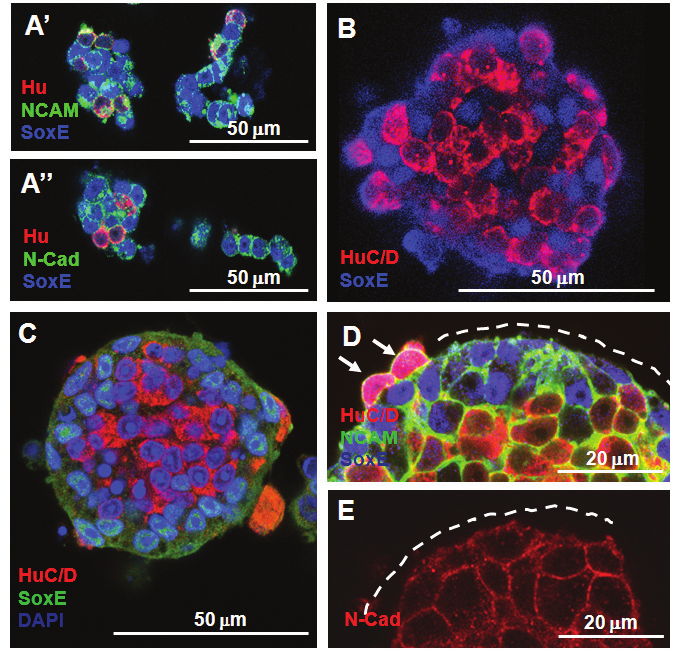
Figure 6. Formation of aggregates by ENS cells in cell-cell adhesion assays correlates with adhesion molecule expression pattern. A’ A’’ . At 2 h QE8 N-cadherin and NCAM +ve ENS cells formed small aggregates (mixed Hu +ve neurons and SoxE +ve ENC cells) and chains (mostly ENC cells). B . At 6 h spherical aggregates were formed but neurons (HuC/D +ve ) and ENC cells (SoxE +ve ) were only partially segregated. C . At 18 h most HuC/D +ve neurons formed the centre of each spherical aggregate surrounded by SoxE +ve ENC cells. D . NCAM immunoreactivity was low on the external face of SoxE +ve ENC cells (indicated by dotted line), but high around HuC/D +ve neurons, whether these were located centrally or on the periphery (arrows). E . N-cadherin immunoreactivity was associated with all cells in the aggregate, but was less distinct on the external surface (indicated by dotted